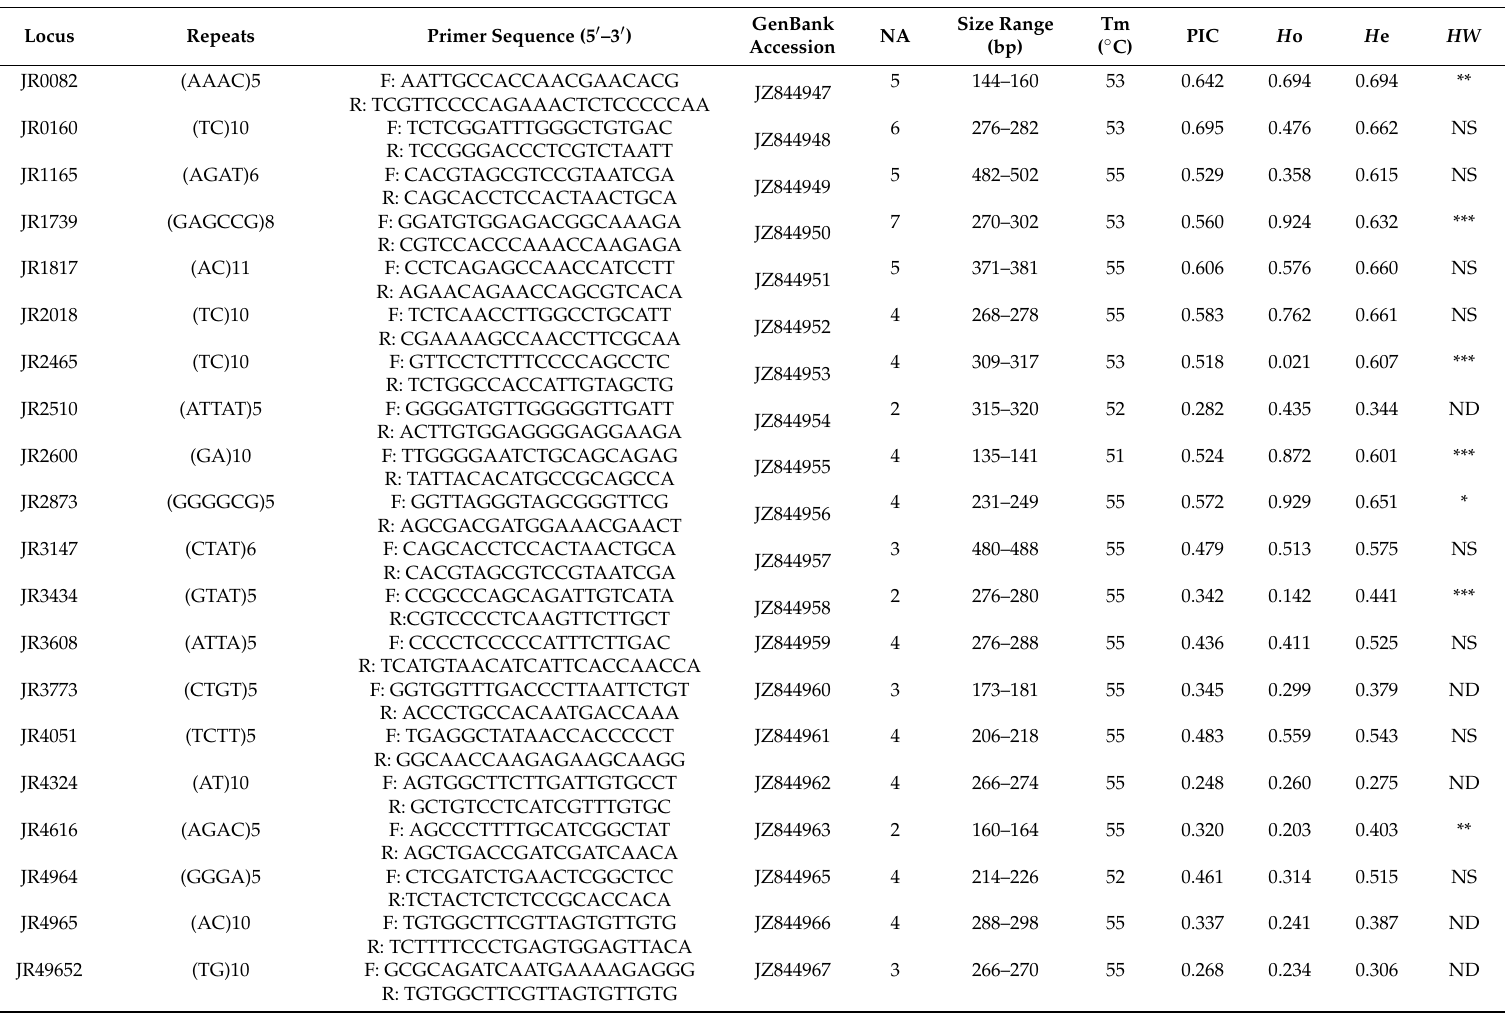
Table 2. Characterization of 39 polymorphic microsatellite loci of 77 tested EST-SSRs of Juglans regia